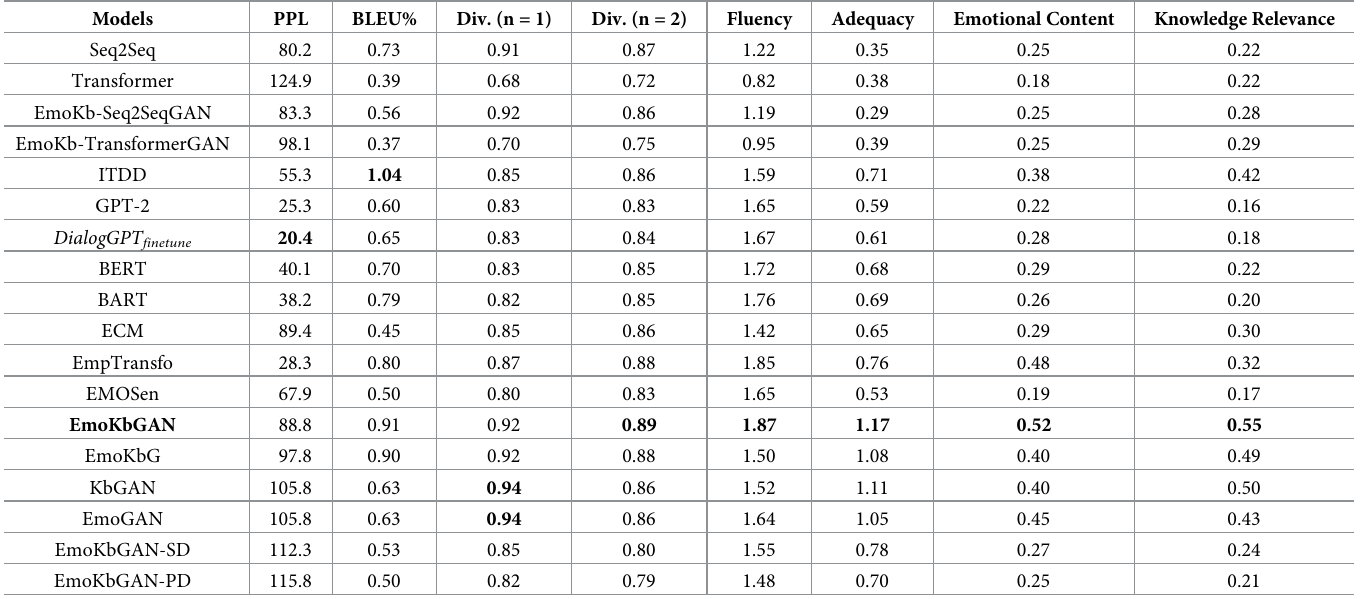
EmoKbGAN-PD Bold face indicates leading results for each